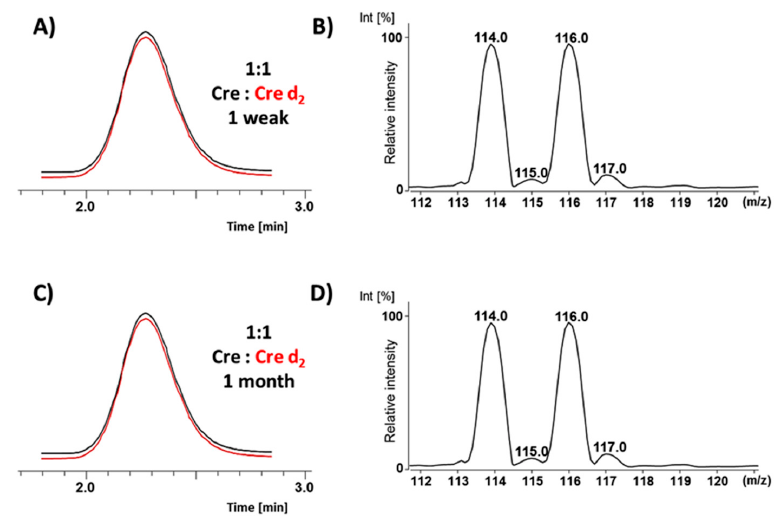
Figure 4. The ( A , C ) LC-MS and ( B , D ) ESI-MS analysis of the stability of the obtained deuterated Cre standards after ( A , B ) one week and ( C , D ) one month of storage in the mixture of H 2 O / MeCN / HCOOH (1:1:0.1 v / v / v ). Extracted ion chromatograms of non-deuterated (Cre, black line) and deuterated (Cre d 2 , red line) creatinine samples mixed in a 1:1 ratio.